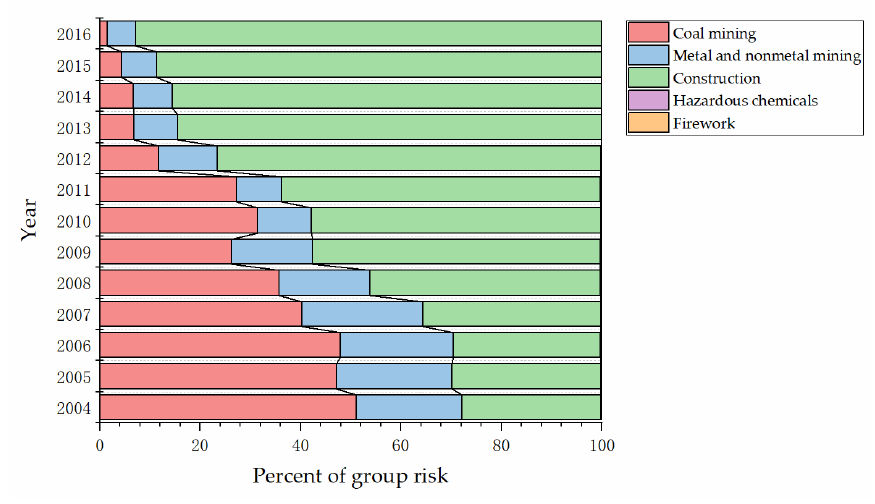
Figure 3. Percent stacked bar of group risk of each high-danger industry to the whole.